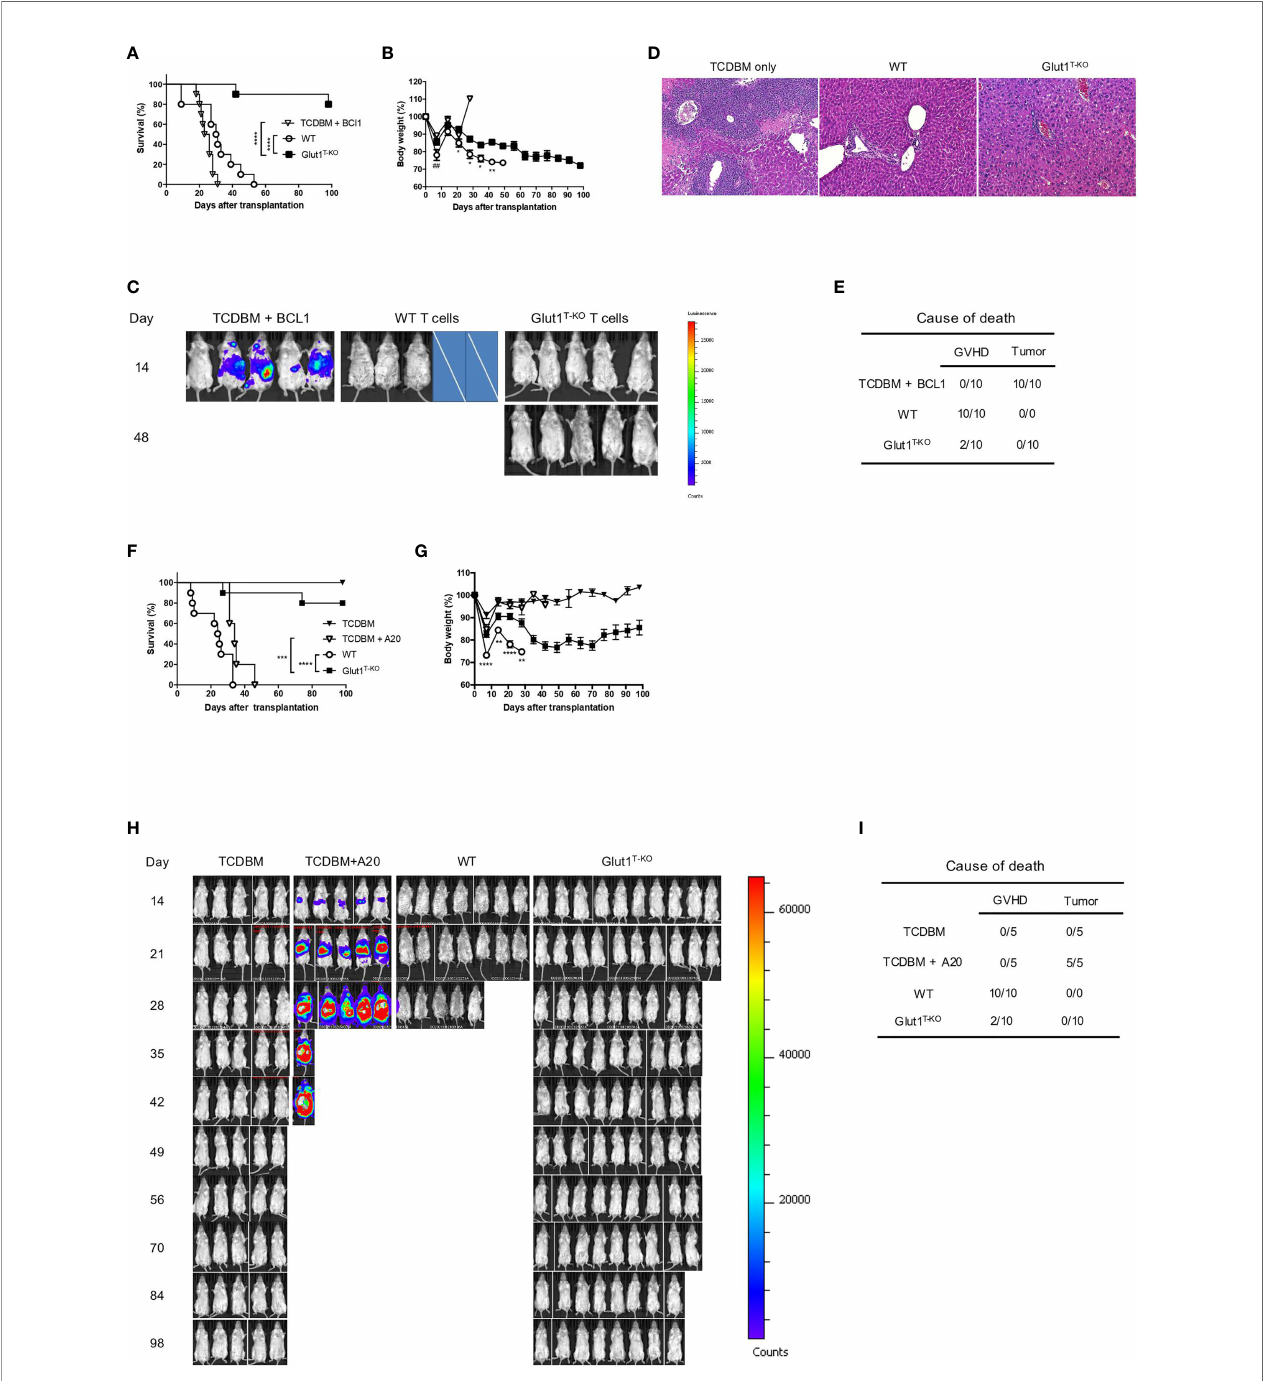
FIGURE 4 | Transfer of Glut1 T-KO T cells inhibits GVHD development and spares GVL activity. Lethally irradiated (8.5 Gy) BALB/c recipients were transplanted with 1 x 10 6 WT or Glut1 T-KO T cells, along with 1 x 10 7 TCDBM and 5 x 10 5 BCL1 cells. Recipients were monitored for survival (A) and body weight (B) up to 100 days after transplantation. Development of leukemia/lymphoma (C) was monitored by BLI. Cross symbols indicate death prior to BLI. H&E histology (10x & 40x) of liver (D) from recipients was assessed (time at sample collection: TCDBM + BCL1, day 21; WT, day 27; Glut1 T-KO , day 105). Cause of death due to GVHD or tumor development was summarized (E) . (F) Lethally irradiated (8.5 Gy) BALB/c recipients were transplanted with 1 x 10 6 WT or Glut1 T-KO T cells, along with 1 x 10 7 TCDBM and 1 x 10 5 A20 cells. Recipients were monitored for survival (F) and body weight (G) up to 100 days after transplantation. Development of leukemia/lymphoma (H) was monitored by BLI. Cause of death due to GVHD or tumor development was summarized (I) . ***P < 0.001, ****P < 0.0001, log-rank test (A, F) ; *P < 0.05, **P < 0.01, ****P < 0.0001 (Glut1T-KO vs. WT); ## P < 0.01 (TCDBM vs. WT), 2-tailed Student t test (B, G) . Data are representative of three experiments (n = 10 per group, 1 x 10 6 T cell